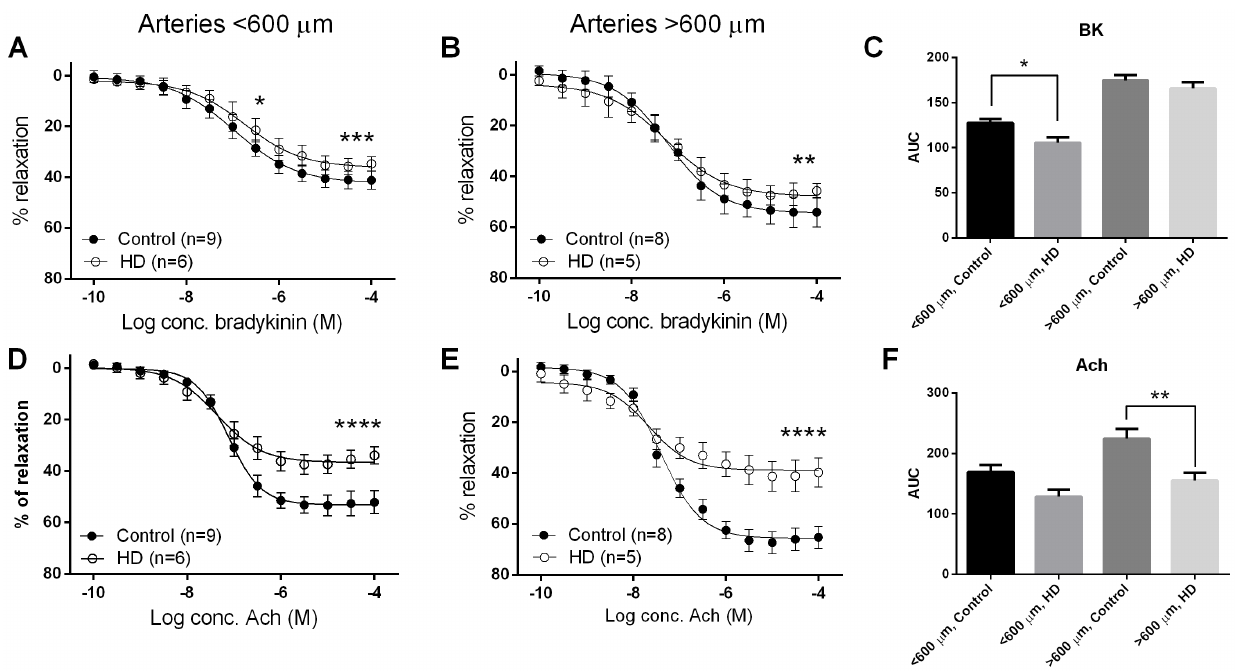
Fig. 3. Concentration-response curves to bradykinin (A,B,C) and acetylcholine (D,E,F) in arteries obtained from HD patients and controls. Data are expressed as mean ¡ SEM and the comparison is by students t-test; * P , 0.05, ** P , 0.01, *** P , 0.001, **** P , 0.0001. HD, haemodialysis; n, number of arteries; M, molar.